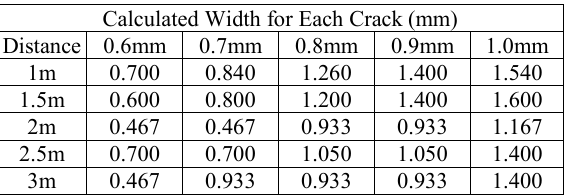
Table 6. The calculated width for each crack. After that, the error rate can be calculated using the Equation 2.